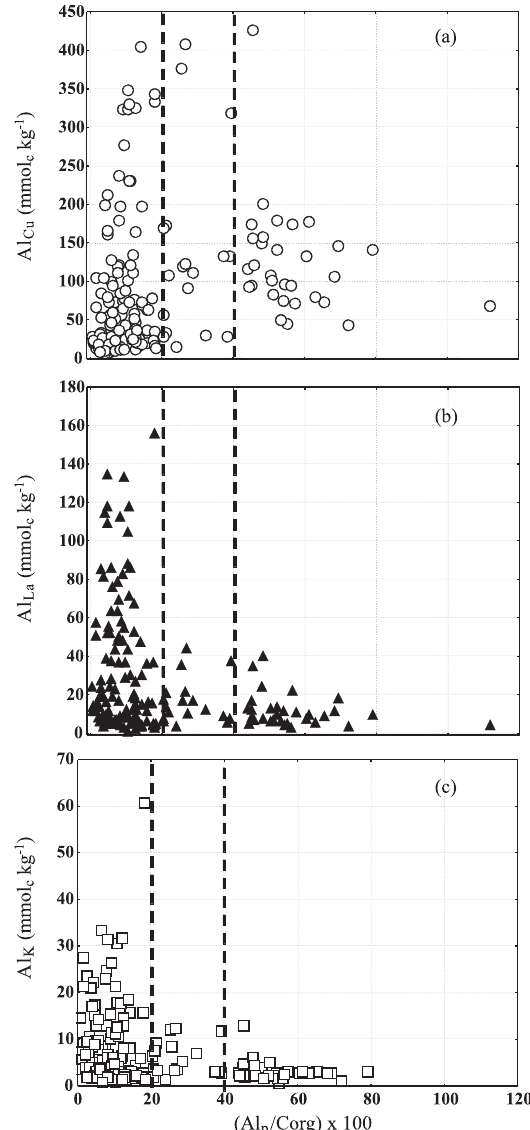
Figura 7. Relação entre (Al